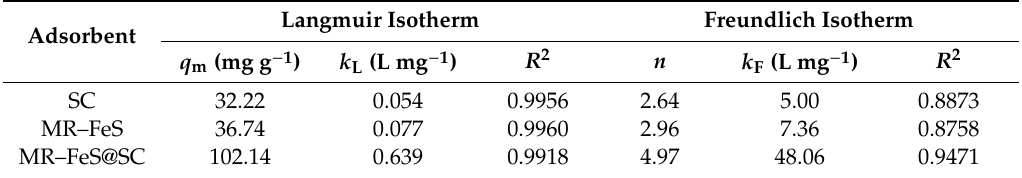
Table3. LangmuirandFreundlichisothermsparametersfortheadsorptionofSTbydi ff erentadsorbents.